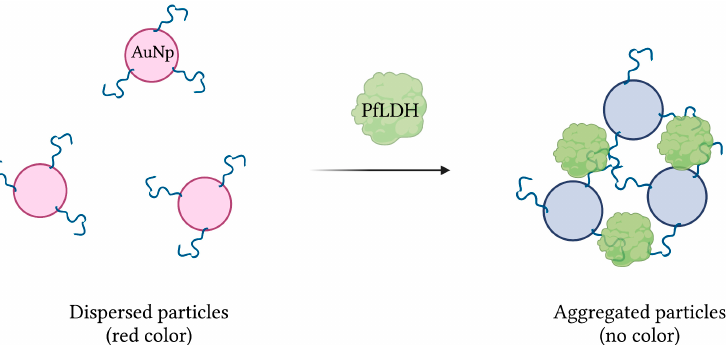
Figure 7. The schematic illustration of the colorimetric-based aptasensor for Plasmodium falciparum LDH detection. Adapted with permission from [42]. Aptamer-conjugated AuNps aggregate in the presence of Pf LDH, resulting in a detectable loss of their red color. Created with BioRender.com (accessed on 19 December 2021).